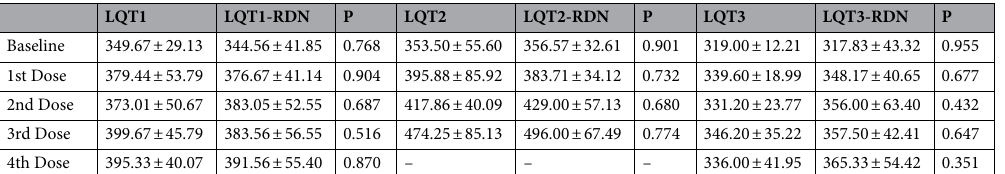
Table 1. The SR CL (ms) measurements from baseline to the sequentially increased doses of all LQTS subtype induction (LQTS induction drugs and doses are described in the “Methods” section).